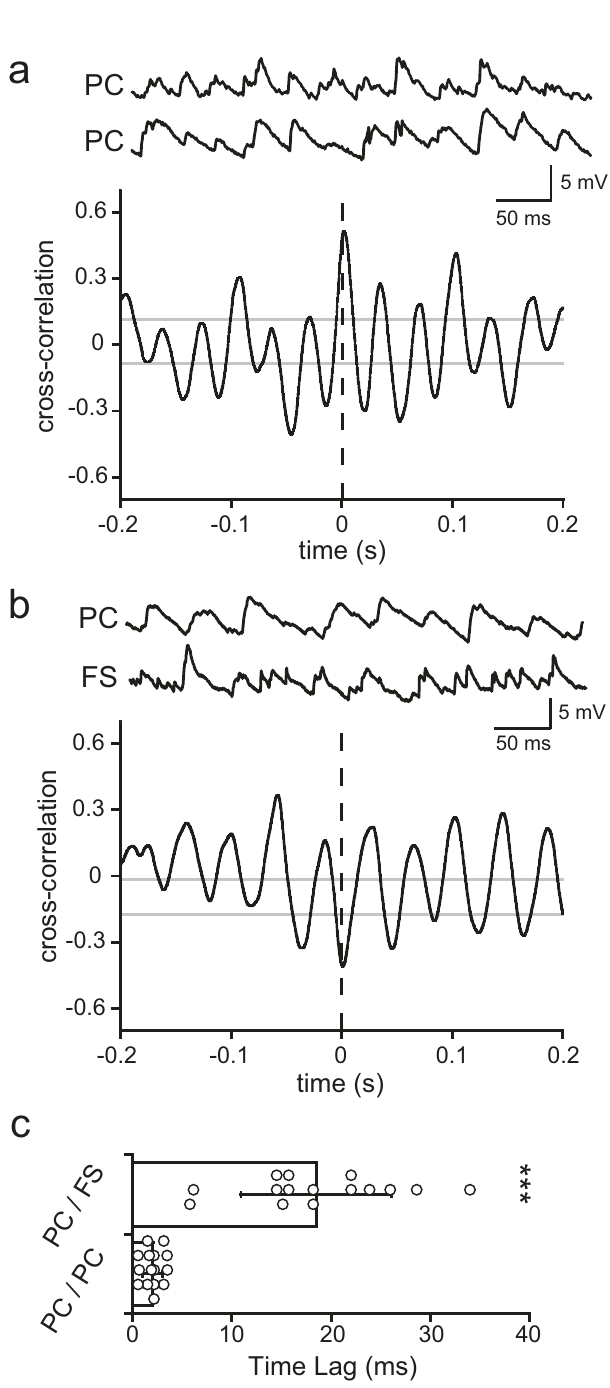
Fig. 2 Cross-correlation analysis between L5 cells during oscillatory activity. a Dual recordings from L5 PCs (upper) and a cross-correlogram. b Dual recordings from a PC and a FS cell in L5, and a cross-correlogram (PC, point of reference). Dashed line indicates time 0. Gray lines indicate 95% con fi dent intervals. c Temporal differences between time 0 and the nearest positive peak in cross-correlograms of PC/PC pairs ( n = 15) and PC/FS cell pairs ( n = 15). ***, a signi fi cant difference ( P < 0.0001, Wilcoxon signed-rank test). Data are expressed as mean ±